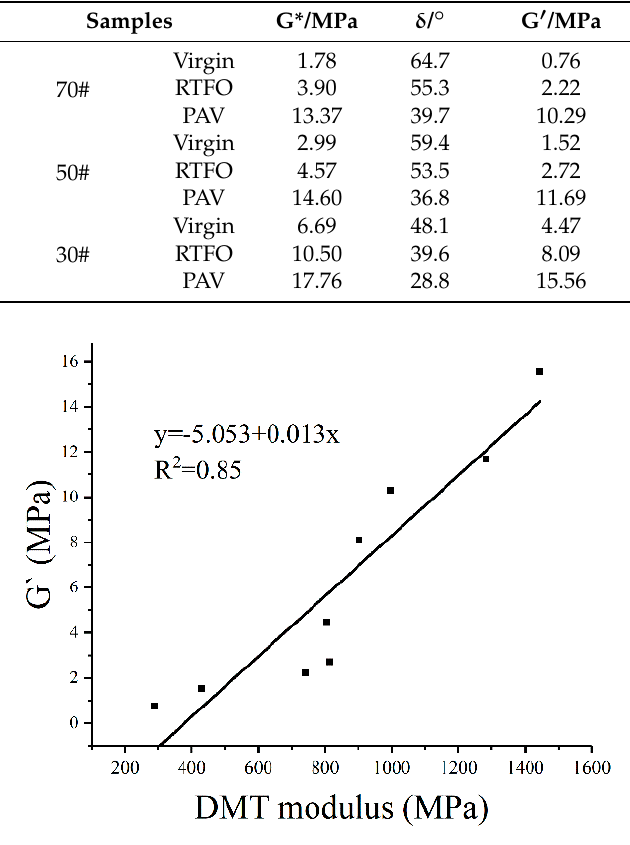
Figure 7. Relationship between the DMT modulus and G’.